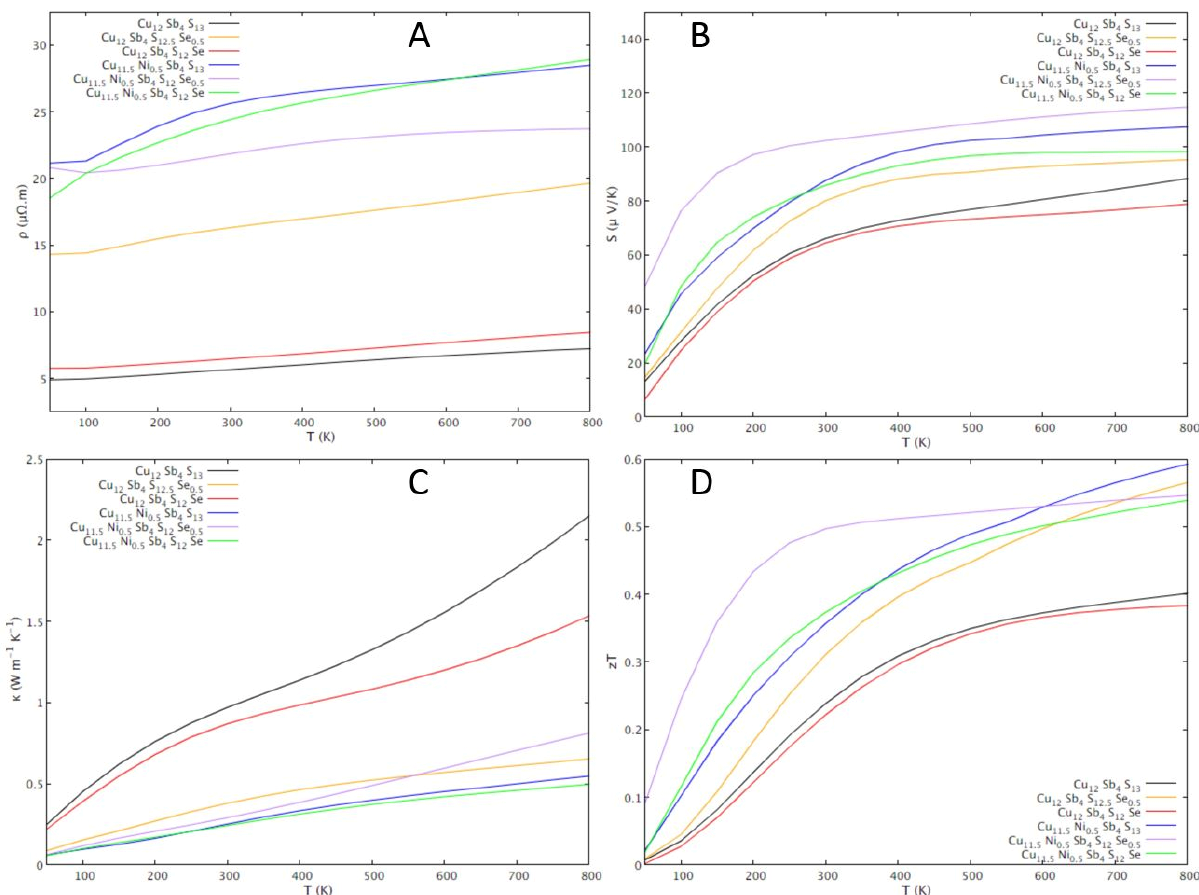
Figure 3. BoltzTrap simulations of the temperature dependence of thermoelectric properties of tetrahedrite with different dopant contents following the formula Cu 12 − x Ni x Sb4S 13 − y Se y (0 ≤ x ≤ 1.0; 0 ≤ y ≤ 1.0): ( A ) Seebeck coefficient; ( B ) electrical resistivity; ( C ) thermal conductivity; ( D ) figure of merit, zT.